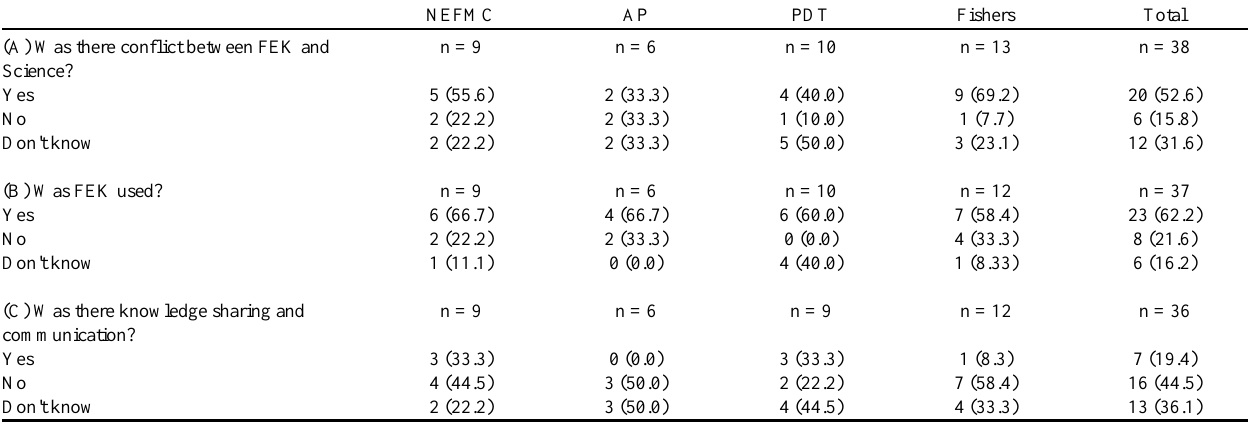
Table 6 . Opinion about the creation of the Western Gulf of Maine Area Closure (WGoMAC) for each of the surveyed groups: (A) Was there conflict between the two knowledge systems during the establishment of the closure? (B) Was fishers’ ecological knowledge (FEK) used in the process of closure establishment? and (C) Were there sufficient levels of communication and knowledge sharing between fishers, scientists, and managers? Values in parentheses are percentages. NEFMC AP PDT